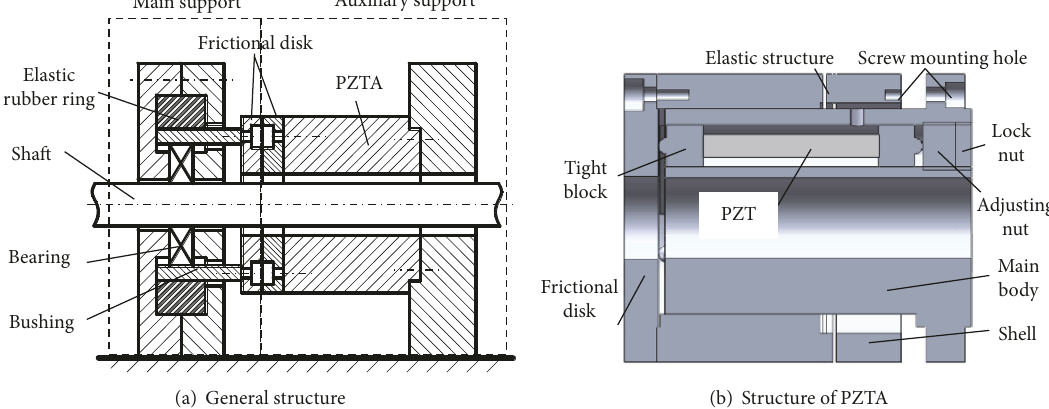
Figure 10: Structure of the Smart Spring support.